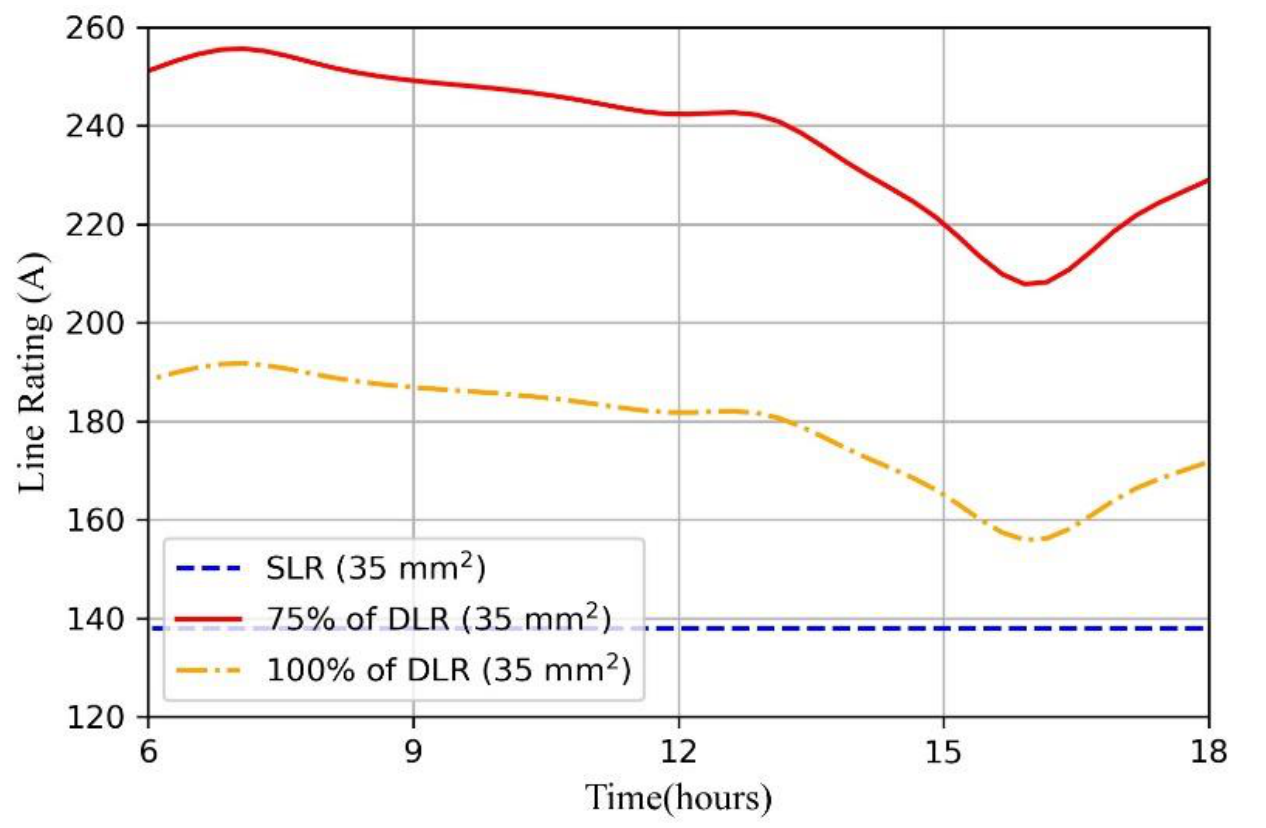
Figure 8. Line ratings of 35 mm 2 ABC cable.